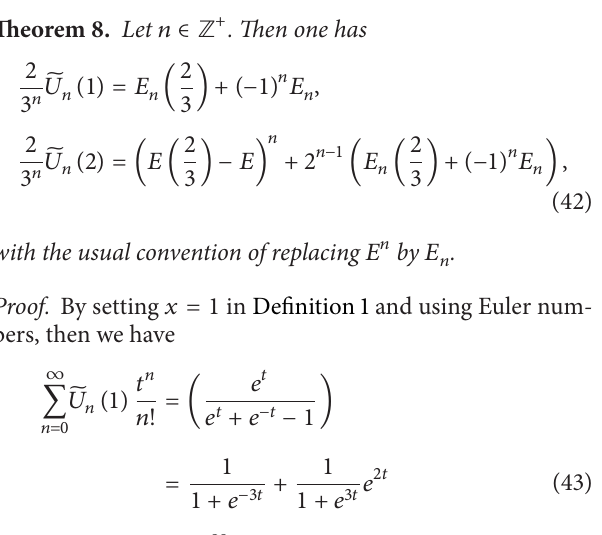
Figure 2: Real zeros of